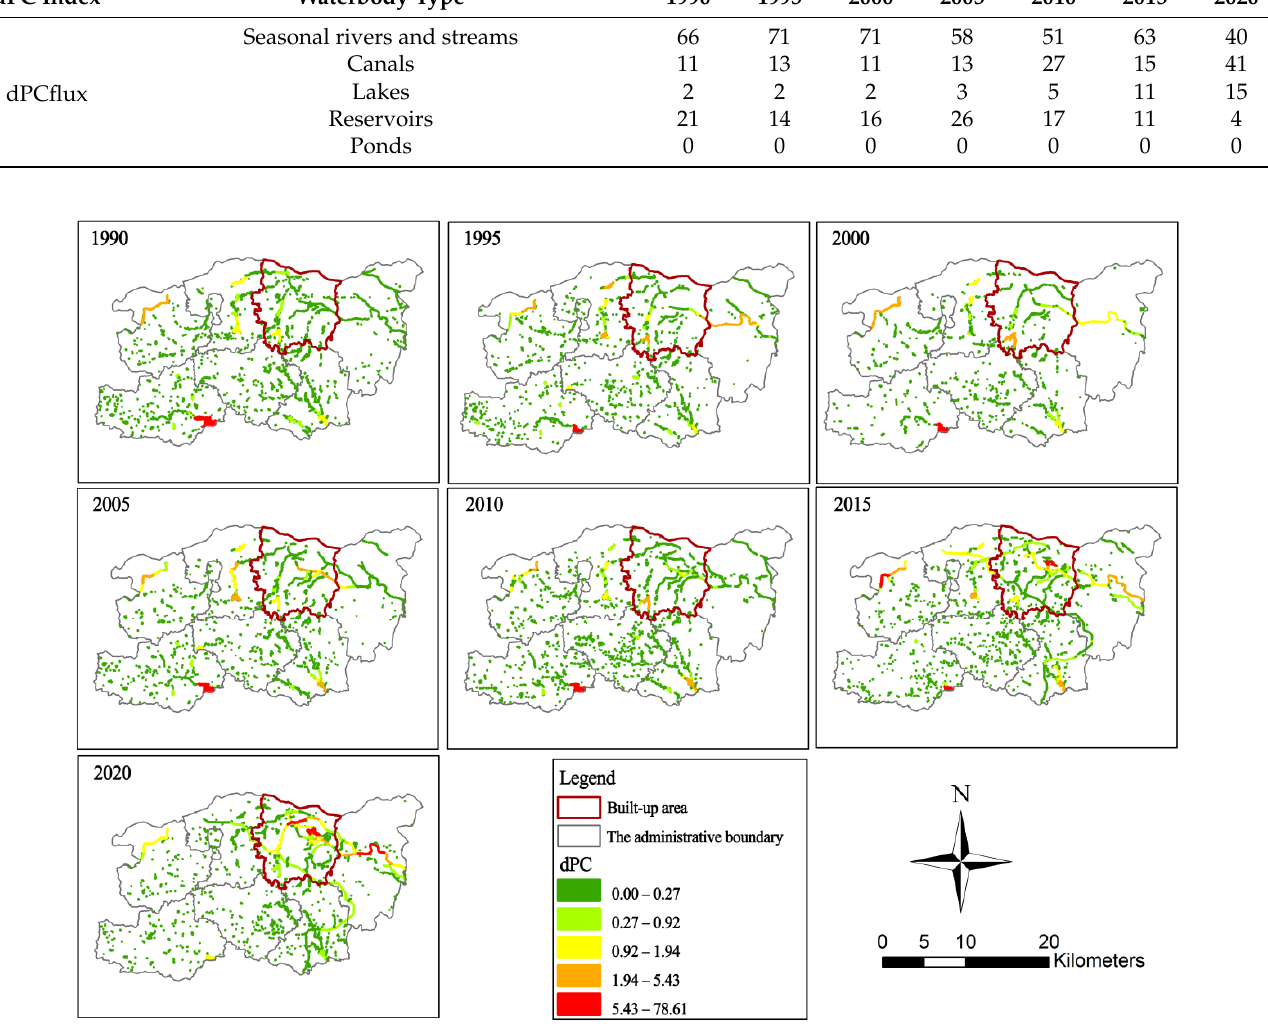
Figure 8. Variation in dPC over a 30-year period in Zhengzhou, China. The index was divided into five categories by the Jenks natural breaks classification method. The perennial river was excluded from the analysis to better understand the changes in connectivity of the other waterbody types in Zhengzhou.